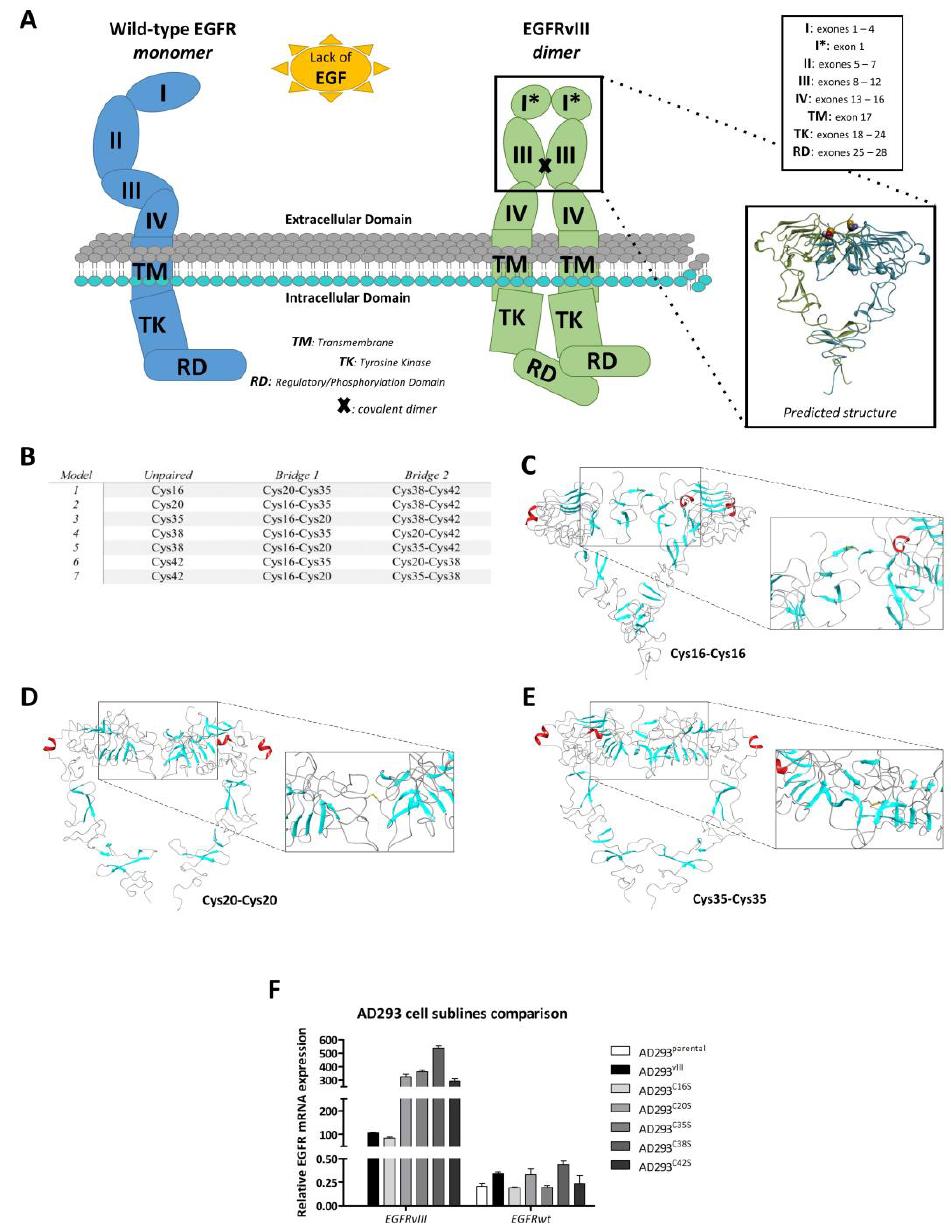
Figure 4. In silico analysis of dimer formation and the discovery of other cysteines were involved in this process in in vitro model development. ( A ) Monomer and dimer schematics. ( B ) All predicted disulfide bonds at the time of cysteine–serine substitution. ( C – E ) Predicted structures of interacting monomers. ( F ) According to the in silico models, the different cysteine–serine mutants, as well as EGFRvIII constructs, were prepared by site-directed mutagenesis of EGFRvIII cDNA and subsequent transformation into the AD293 cell line. Confirmation of expression levels of EGFRvIII and specific EGFRvIII cysteine–serine (C16S, C20S, C35S, C38S, and C42S) in established AD293 cell lines at the mRNA